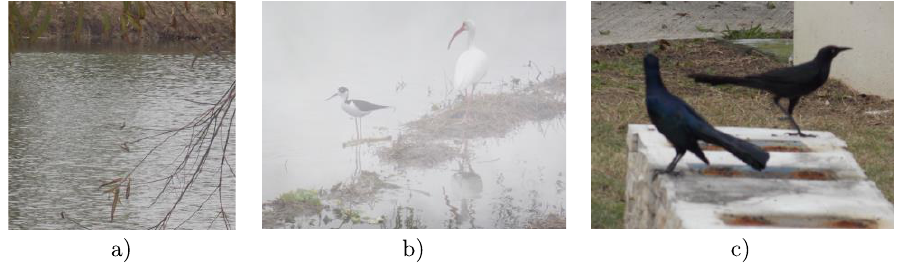
Figure 2. Challenge examples: ( a ) the bird appears occluded. ( b ) The appearance of haze in the image softens the color of the background. ( c ) The image appears with blur to the camera angle [2].